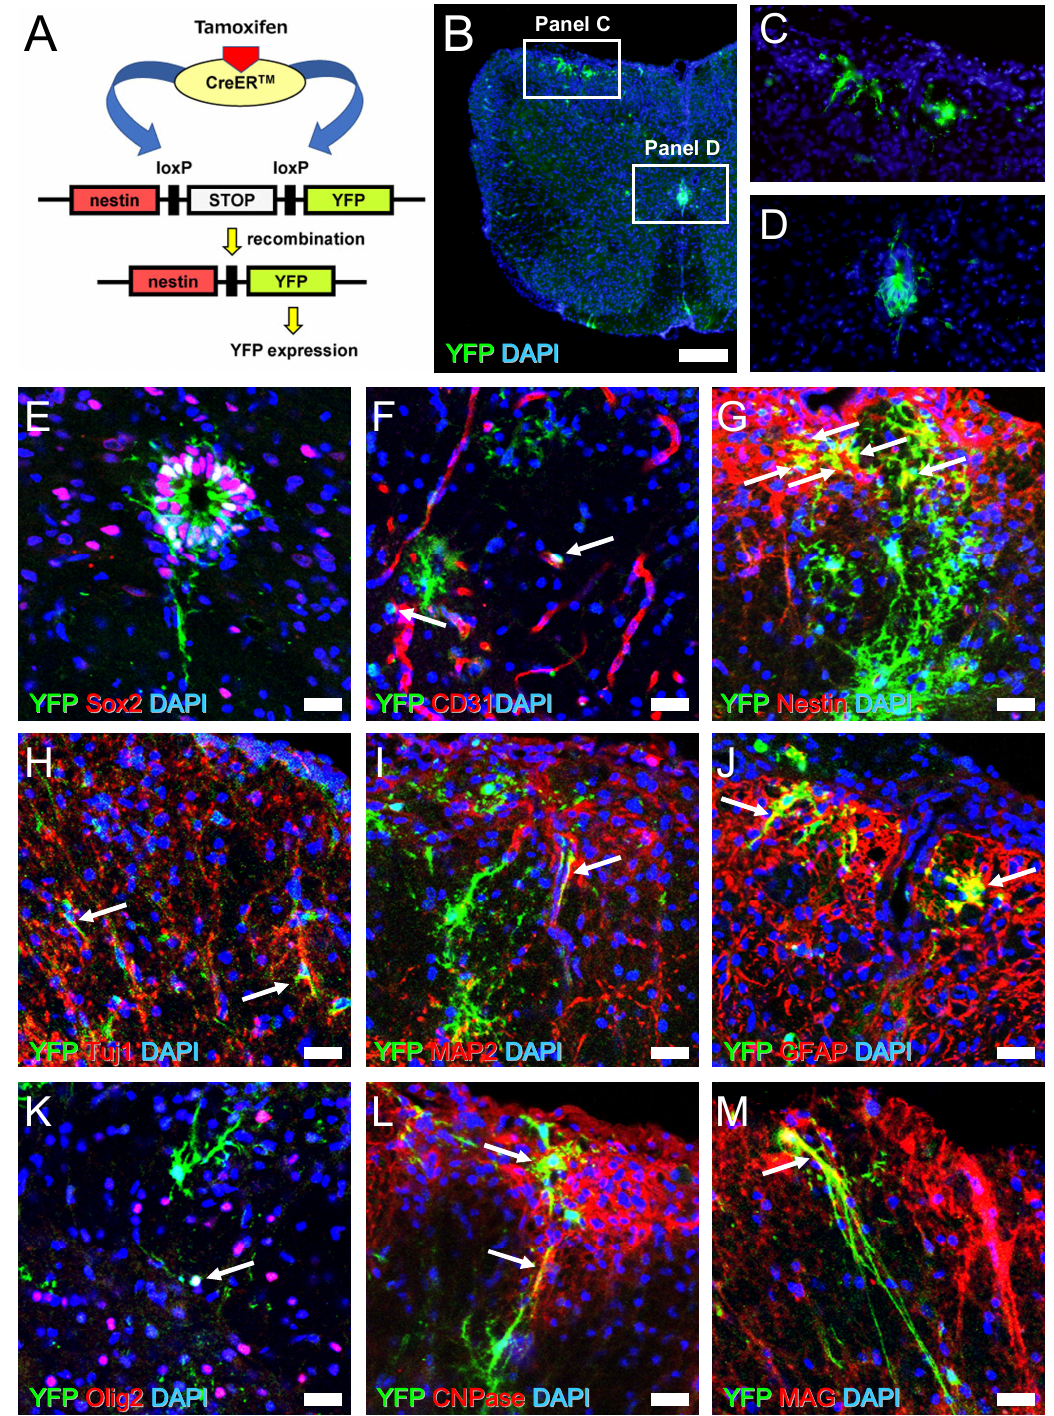
Figure 8. Schematic representation for recombination by tamoxifen injection in Nestin / YFP mice ( A ). Immunohistochemistry showed that YFP + cells are observed in white matter ( B , C ) and central canal ependymal cells ( B , D ) (YFP [ B – D : green] and DAPI [ B – D : blue]). Immunohistochemistry of central canal areas showed that some ependymal cells expressed both YFP and Sox2 (YFP [ E : green], Sox2 [ E : red], and DAPI [ E : blue]). Immunohistochemistry of white matter showed YFP + cells localized near CD31 + blood vessels (YFP [ F : green], CD31 [ F : red], and DAPI [ F : blue]) (arrows). Immunohistochemistry of white matter showed some YFP + cells co-expressed Nestin (YFP [ G :